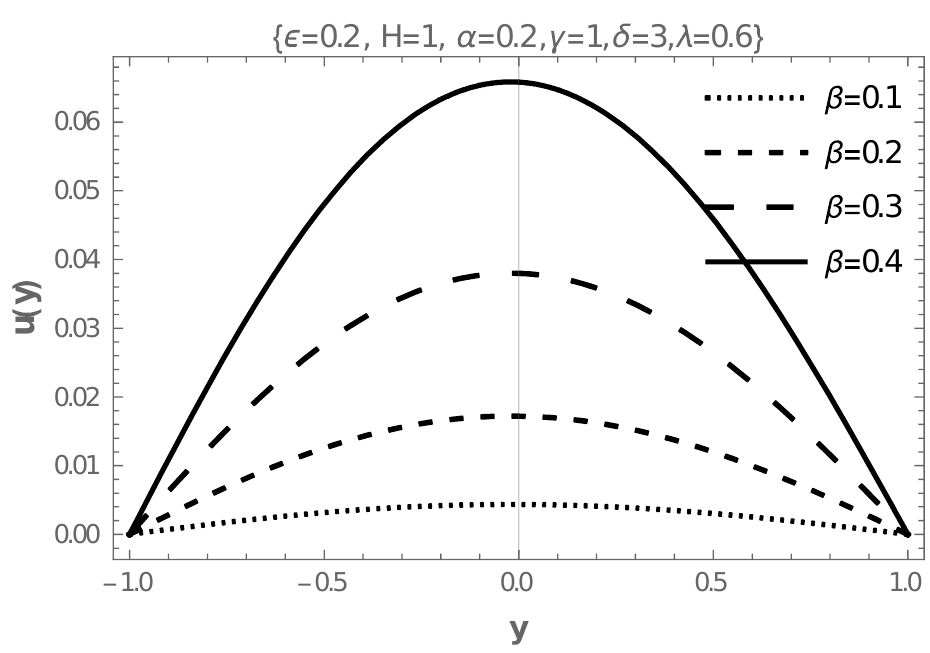
Figure 3. Thermal distribution with viscosity variation parameter ( α ).